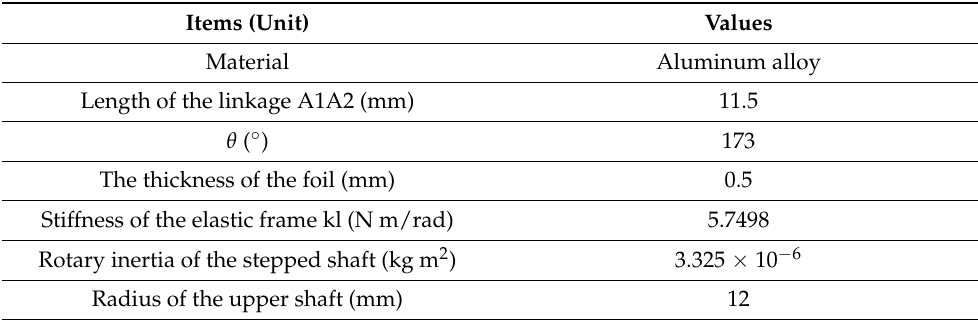
Table 2. Key parameters of the developed device.